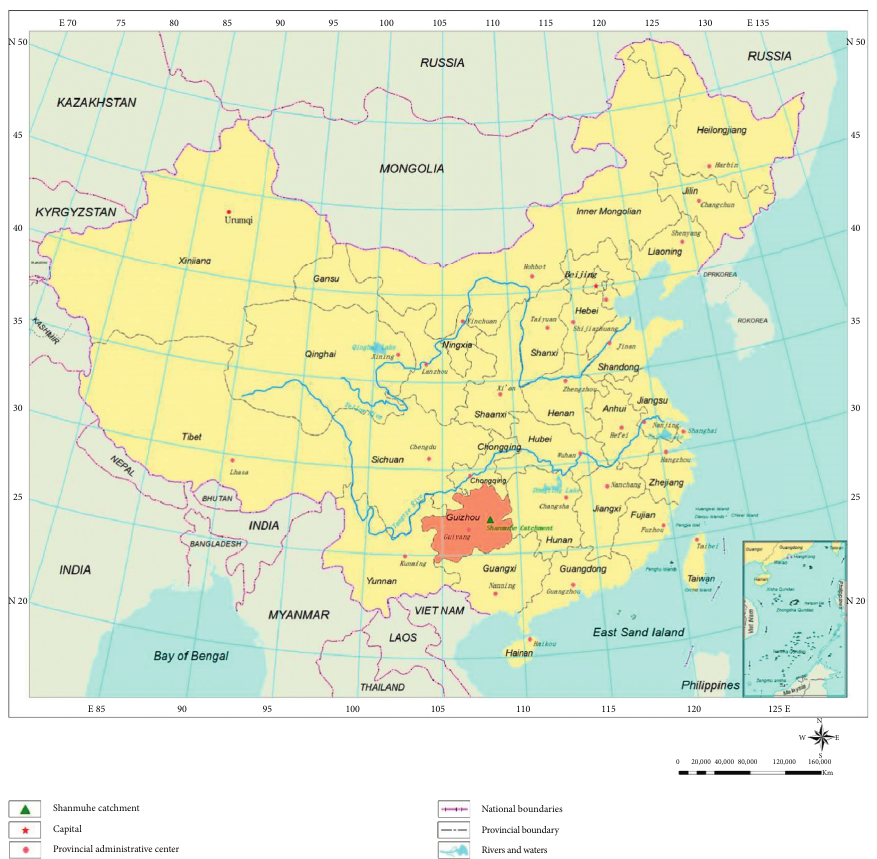
Figure 1: The location of Shibing Karst World Natural Heritage Property, in eastern Guizhou Province,